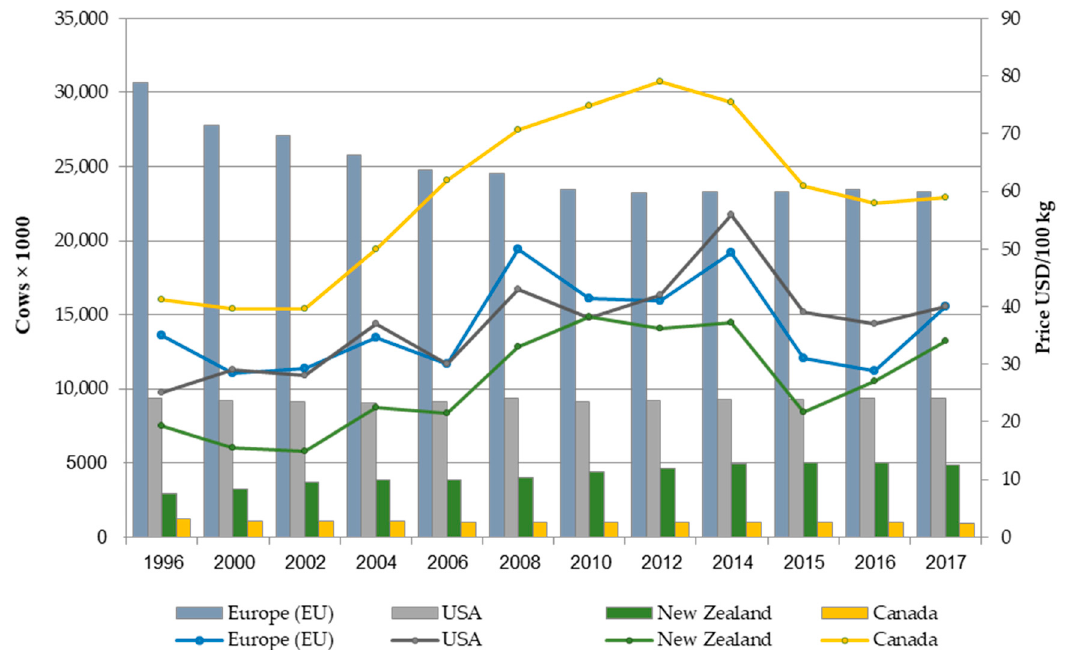
Figure 1. Development of price (right axis, USD/100 kg) and number of cows (left axis, × 1000) in major dairy regions in the world in period 1996 to 2017. Source: IFCN Dairy Research Network